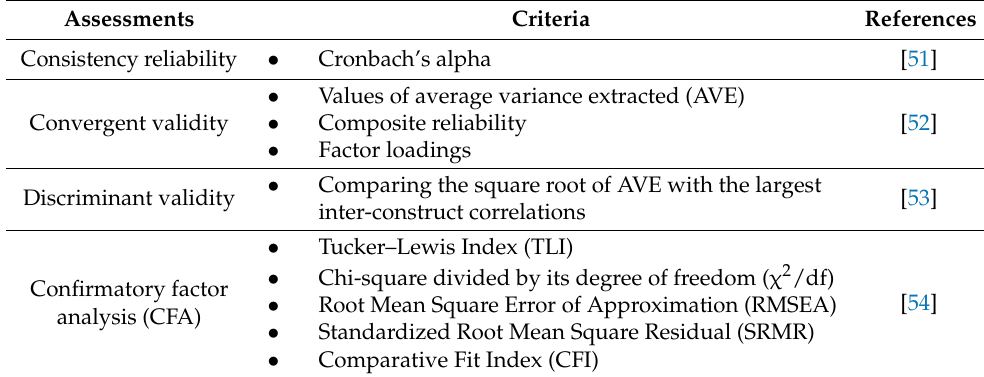
Table 1. Conclusion of statistical analysis and the evaluating